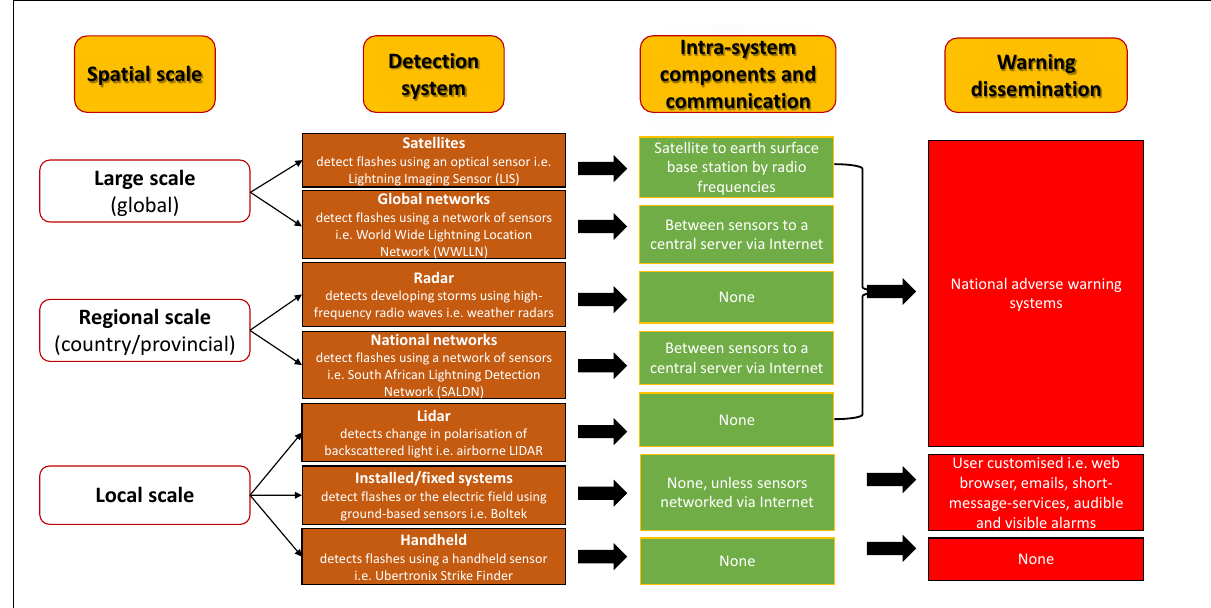
The spatial characteristics of existing lightning detection systems and their associated warning and alert dissemination capabilities.